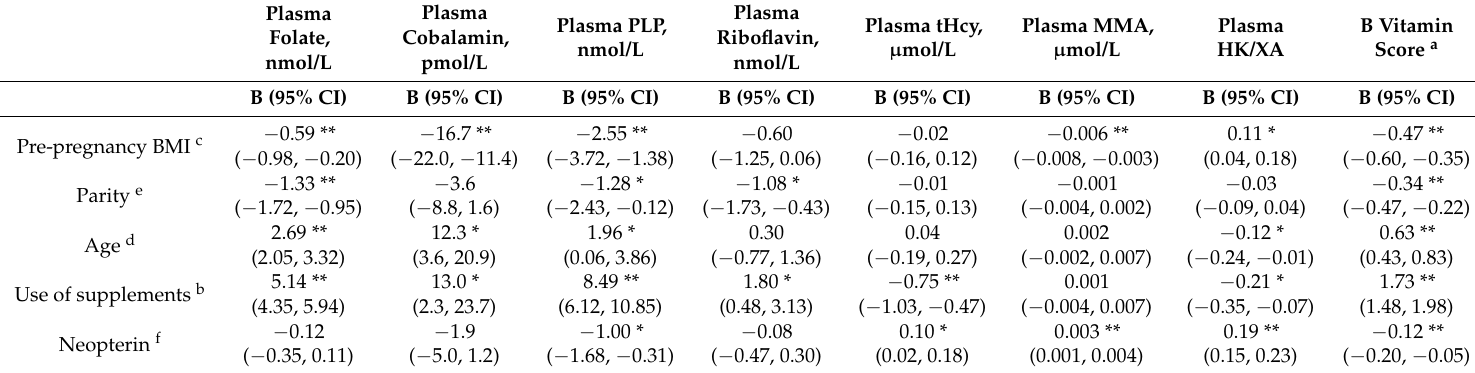
Table 3. Determinants of maternal plasma B vitamin status in pregnancy week 18 by multiple linear regression, n =